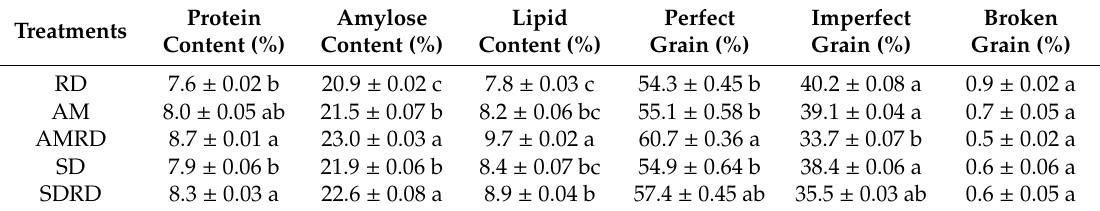
Table 5. Rice grain physicochemical properties in treatments of di ff erent fertilizers application. Treatments